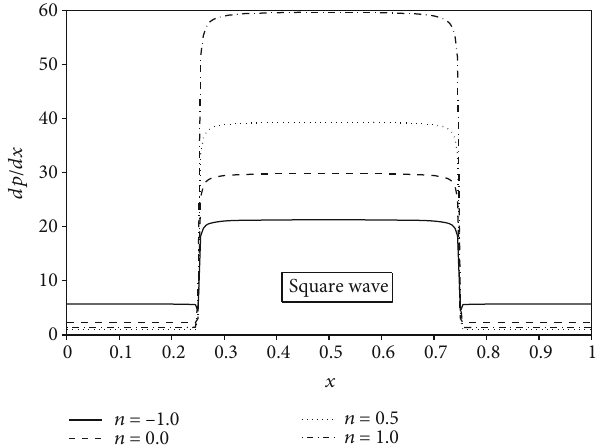
Figure 10: Variation of pressure gradient with x for di ff erent values of n for fi xed values of φ = 0 : 5 , β = 4 , We = 0 : 6 , and Q = − 2